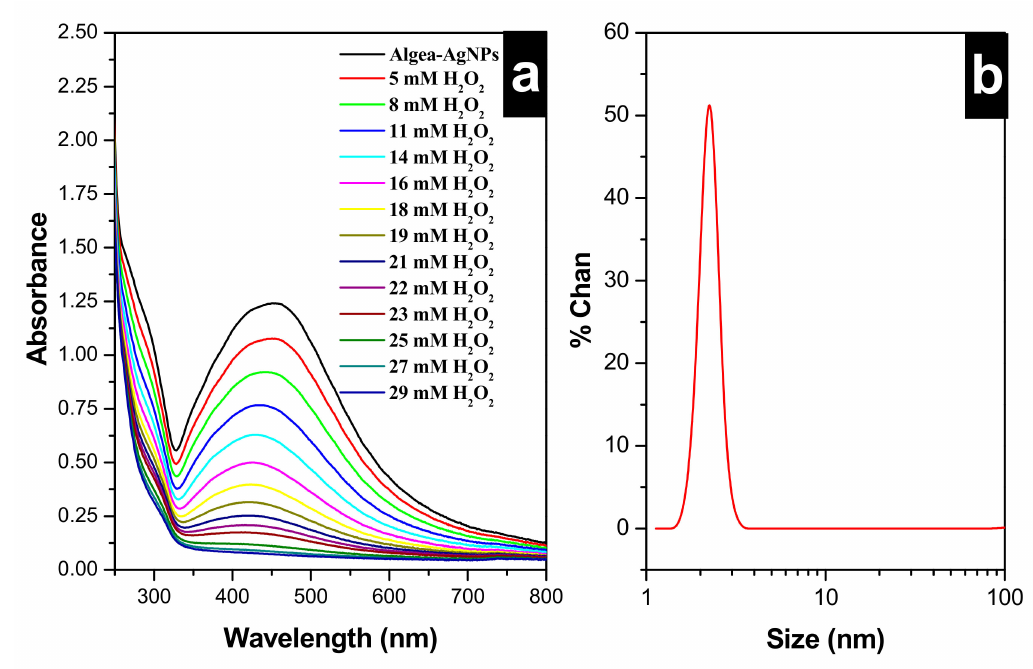
Figure 1. ( a ) UV-Vis responses of Algae-AgNPs solutions upon increasing the concentration of H 2 O 2 from 5.0 to 29 mM. ( b ) Dynamic light scattering showing the size distribution of the algae-capped silver nanoparticles